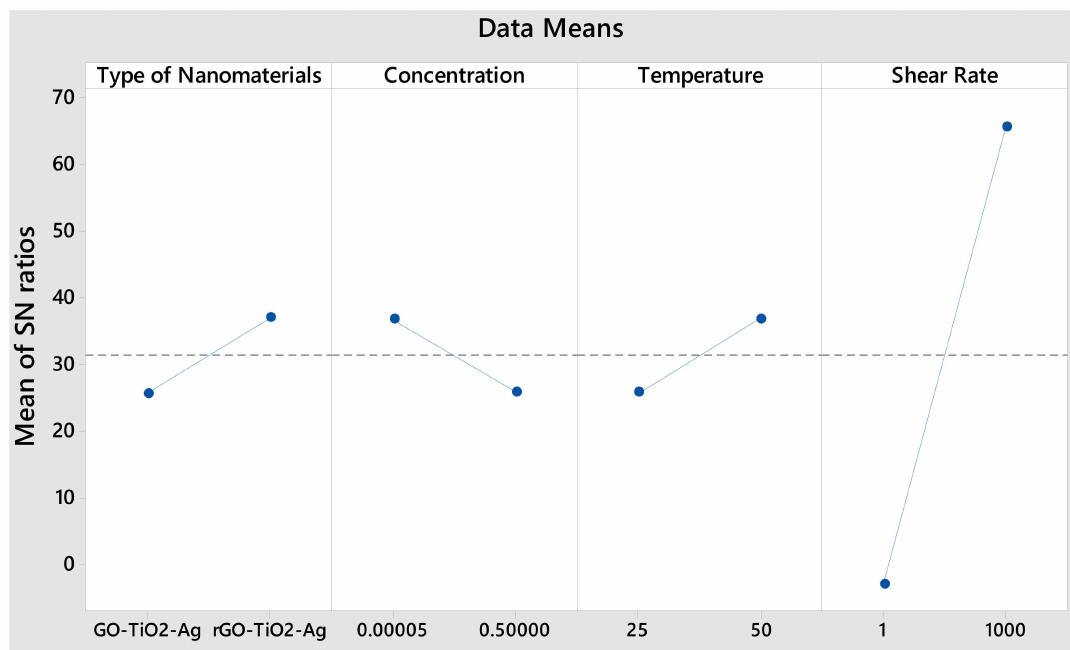
Figure 9. Main effects plot for SN ratios.